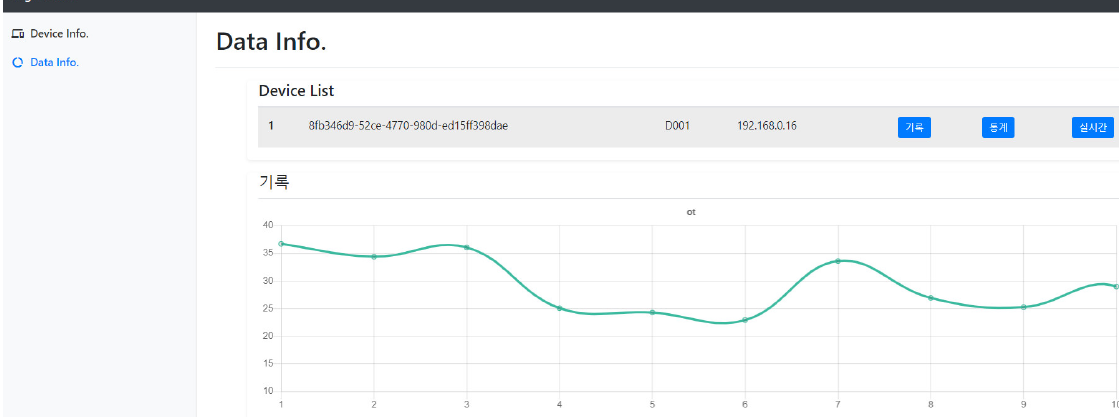
Figure 14. The Implemented Result of History Data of Client Services.